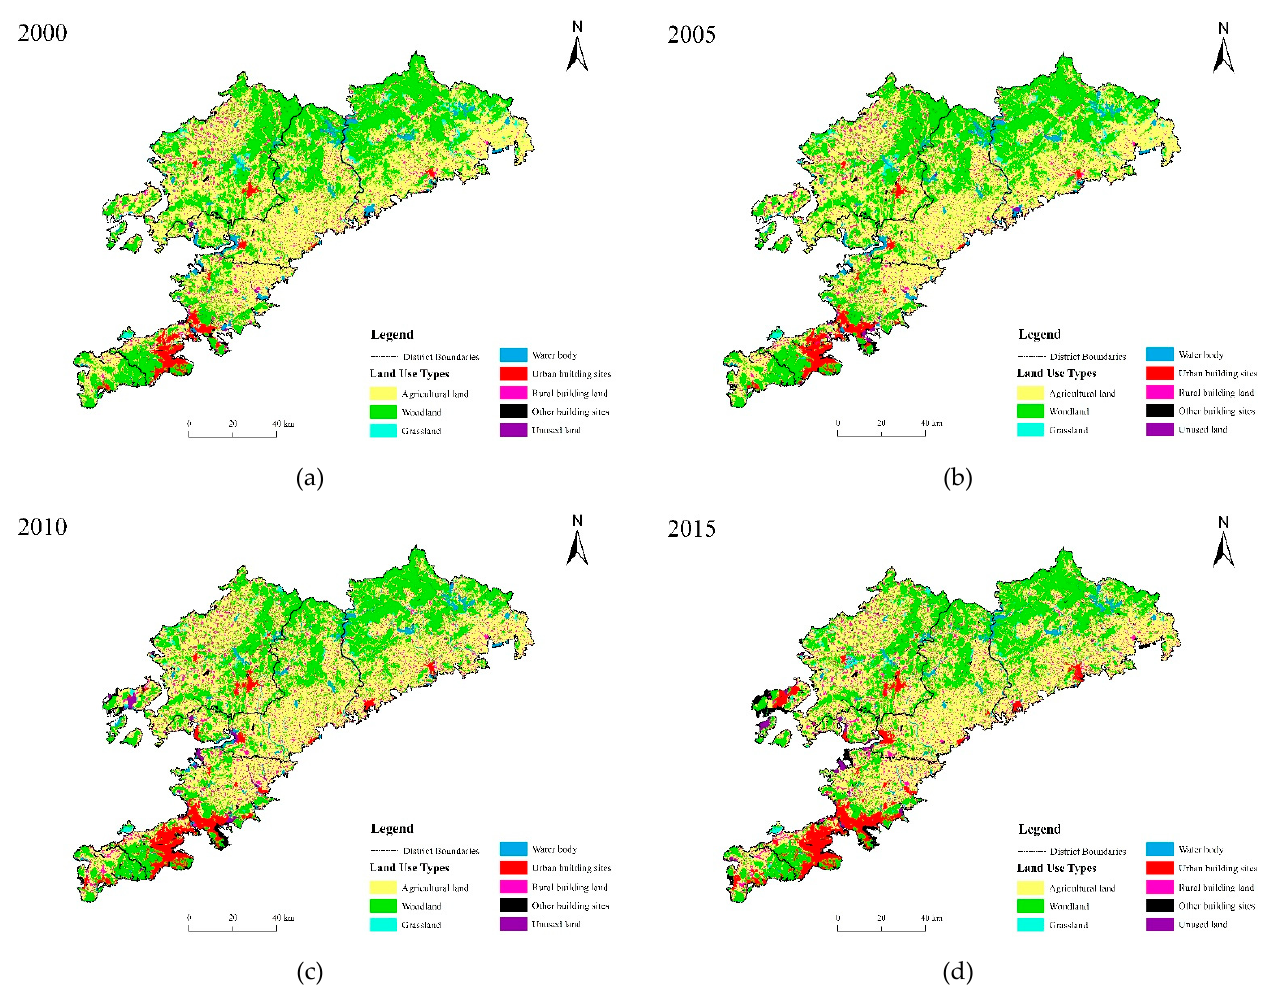
Figure 2. Land use classification map of Dalian City (a) In 2000, (b) In 2005, (c) In 2010 and (d) In 2015. Table 2. Land use classification and